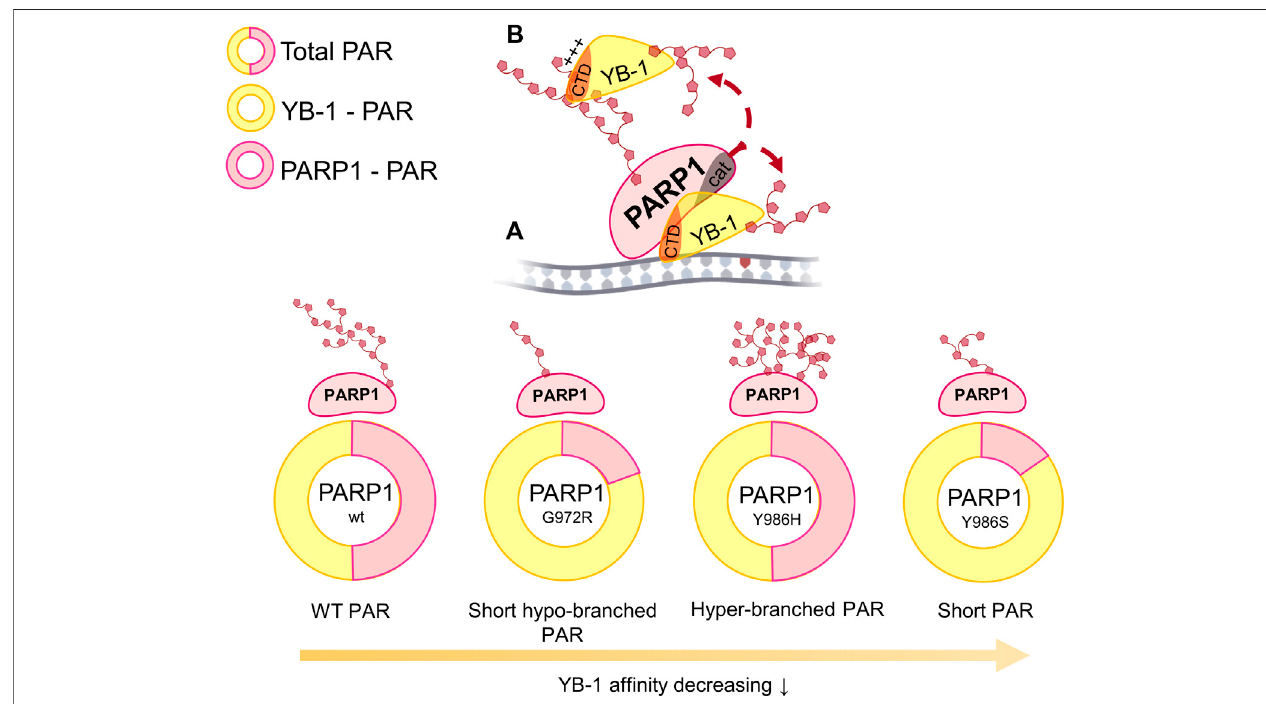
FIGURE10| Thein fl uenceofvariouslengthsandbranchingfrequenciesofthePARsynthesizedbyPARP1pointmutants(Y986H,Y986S,andG972R)ontheYB- 1af fi nitytoPAR,themagnitudeofPARP1auto-PARylation(highlightedinrosy)andYB-1trans-PARylation(highlightedinyellow)duringthestimulationofPARP1activity in ternary complex “ PARP1 – YB-1 – damaged DNA ” (A) as well as during the interaction of YB-1 with PAR via its C-terminal domain (CTD; (B) .